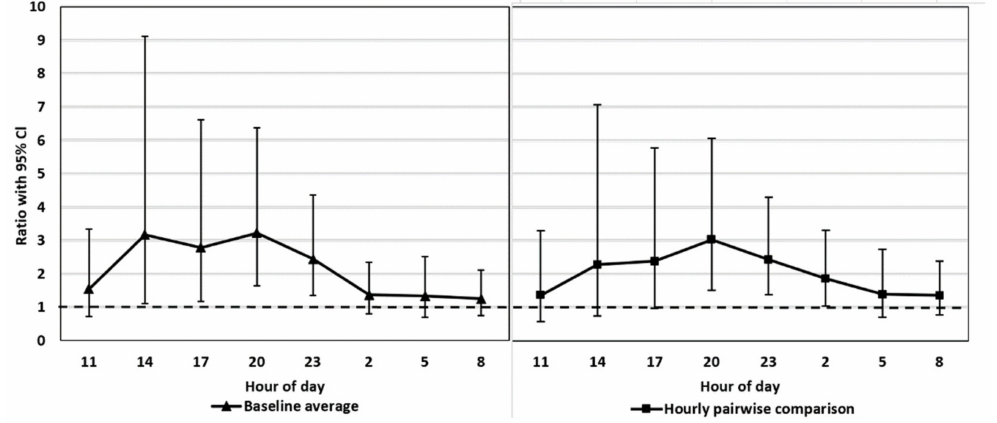
Figure 2. FCM concentrations based on model estimations of the two statistical approaches: 1. Base- line average comparison on the left (Sheet 4 S1) and 2. Hourly pairwise comparison on the right (Sheet 5 S1). Y-axis ratio: mean concentration(s) of control period (dashed line)/mean concentration at each time point of treatment period (95% Cl). The ratio signifies the estimated increase in the treatment period compared to the control period. For example, the peak FCM concentration at 20:00 was 3.2 (baseline average) or 3.0 (hourly pairwise comparison) times higher compared to the reference value from the control period. p < 0.05 if the lower endpoint of the confidence interval stays above 1, e.g., at 20:00 with both